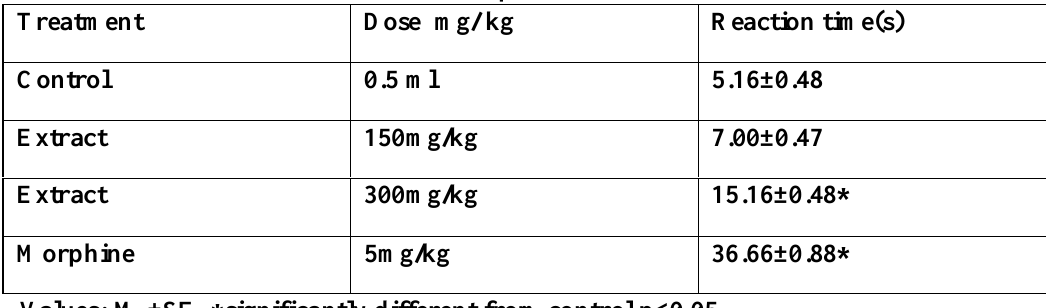
Table 1: Shows the effect of Mentha piperita extract and morphine on hot plate induced pain in mice.